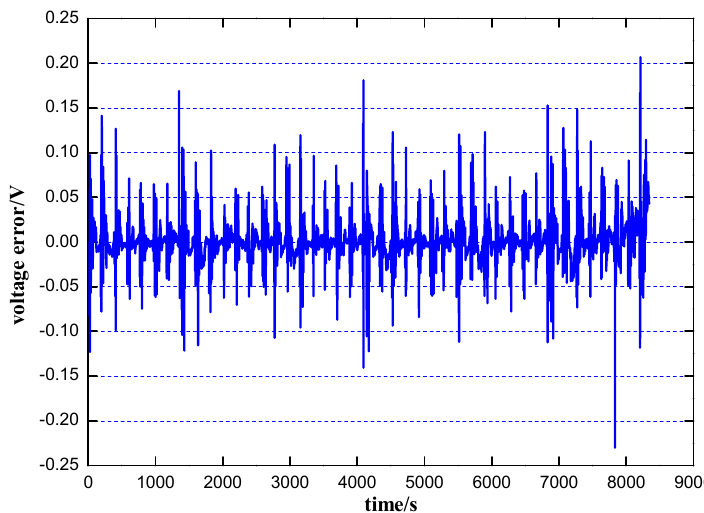
Figure 10. The error between the estimated terminal voltage and experimental terminal voltage of the PCBG with two cells.